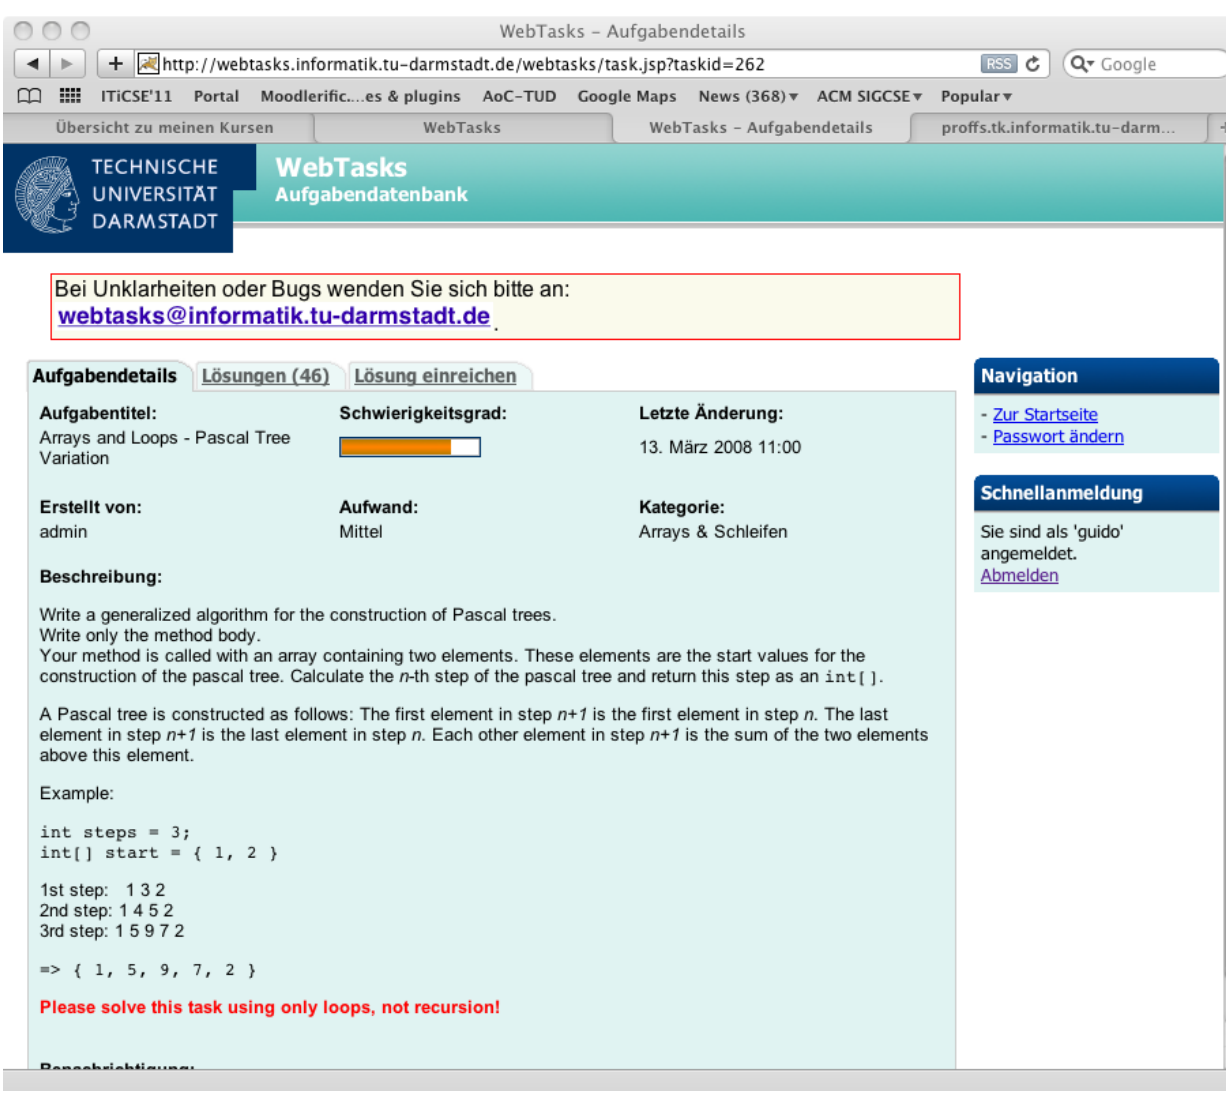
Figure 1. Example task from the WebTasks